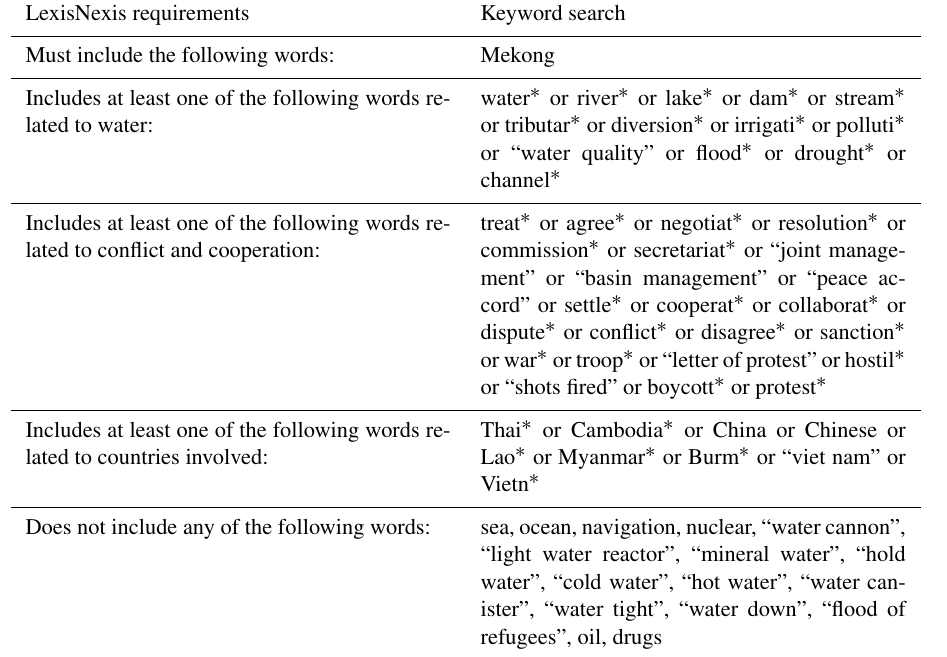
Table 1. Search terms established to generate results. The asterisk is used to represent the root word; i.e. water ∗ means words containing the root word “water” are included.